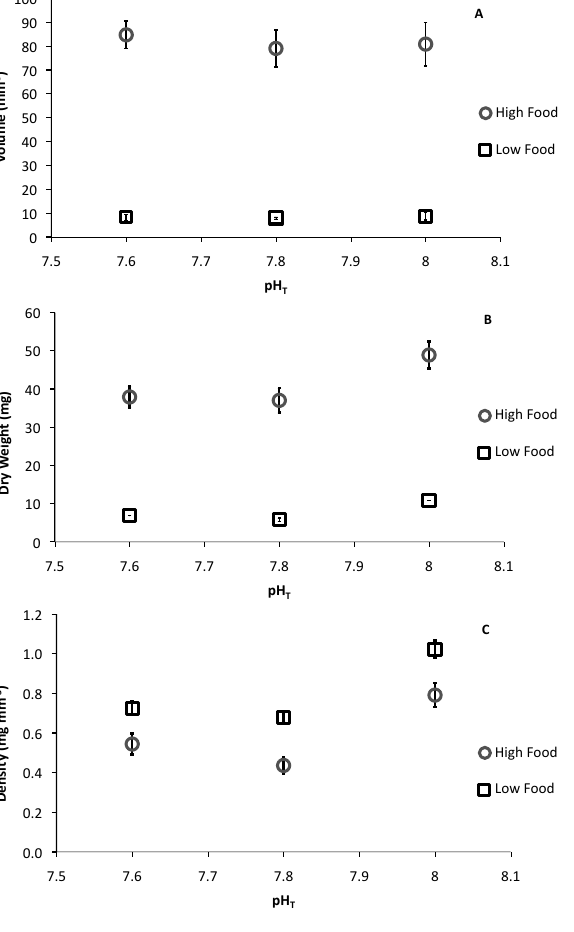
Fig. 4. Means ± s.e.m. for volumes (a) , dry weights (b) , and bulk densities (c) of skeletons of juvenile Balanophyllia elegans after 8 months growth.